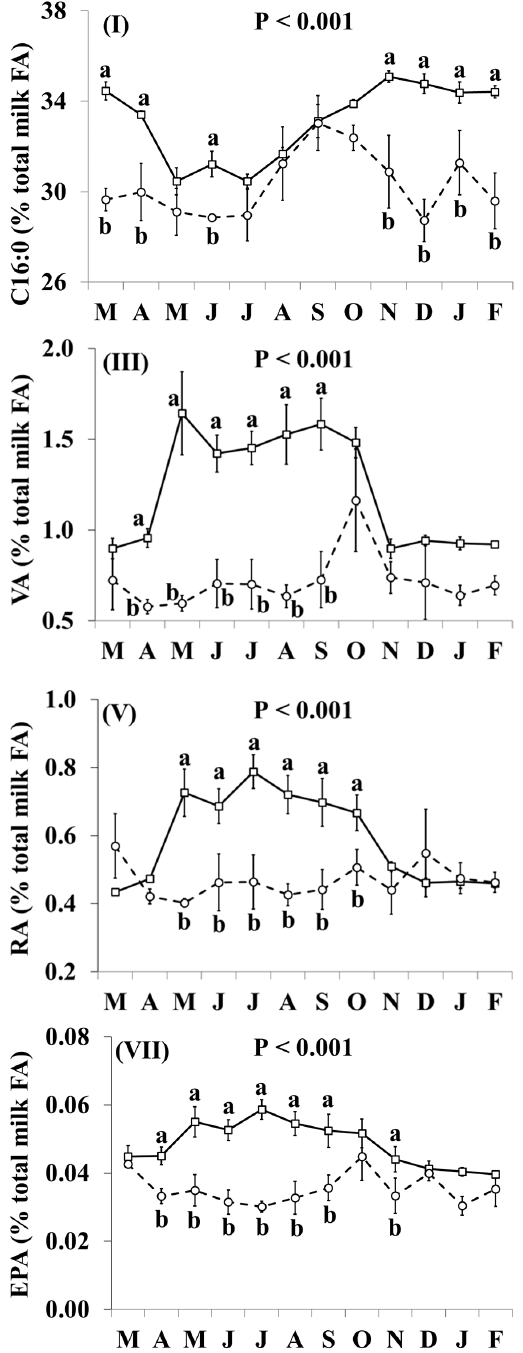
Figure 2. Interaction means ± SE (error bars) for the effects of species (cow, goat) and month (in order of appearance from left to right in Axis X: M, March; A, April; M, May; J, June; J, July; A, August; S, September; O, October; N, November; D, December; J, January; F, February) on the individual fatty acid profile of retail milk: (I) C16:0, palmitic acid; (II) OA, oleic acid; (III) VA, vaccenic acid; (IV) LA, linoleic acid; (V) RA, rumenic acid; (VI) ALNA, α -linolenic acid; (VII) EPA, eicosapentaenoic acid. P represents the ANOVA p -value for the interaction. Means for species and within a month with different lowercase letters are significantly different according to Fisher's Least Significant Difference test ( p < 0.05).